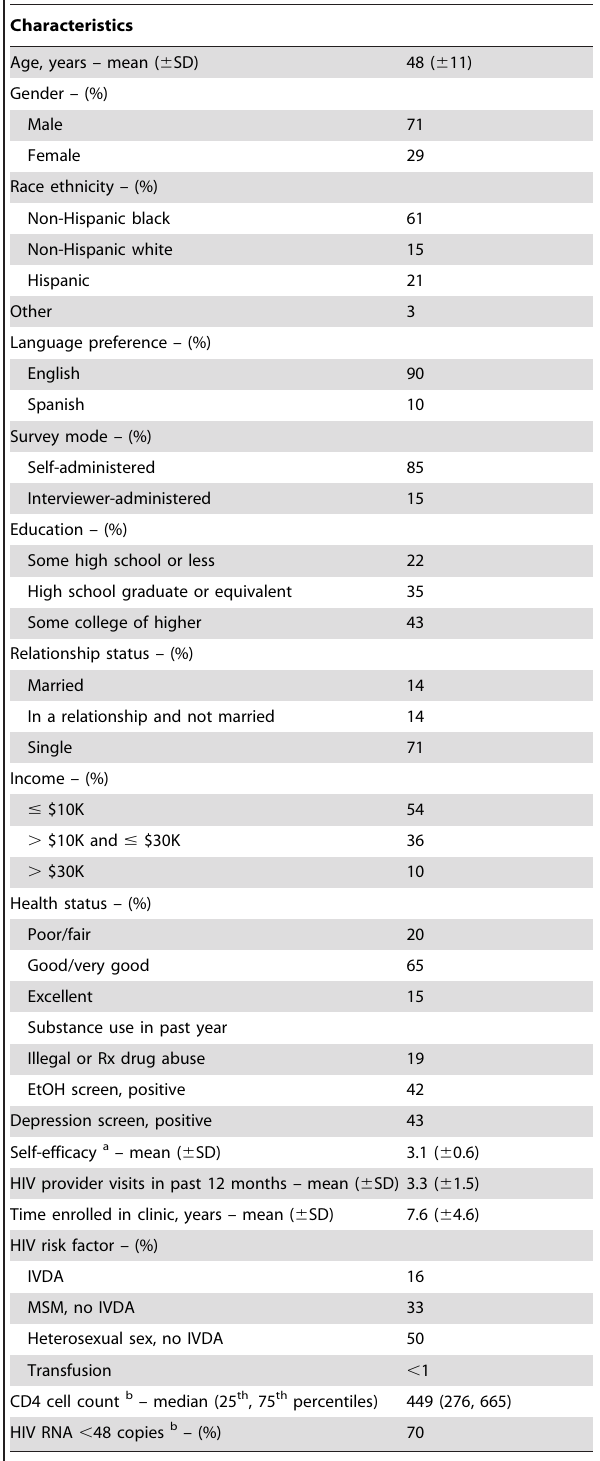
Table 3. Baseline characteristics of participants at Thomas Street Health Center and the Veterans Affairs Medical Center in Houston, Texas (N